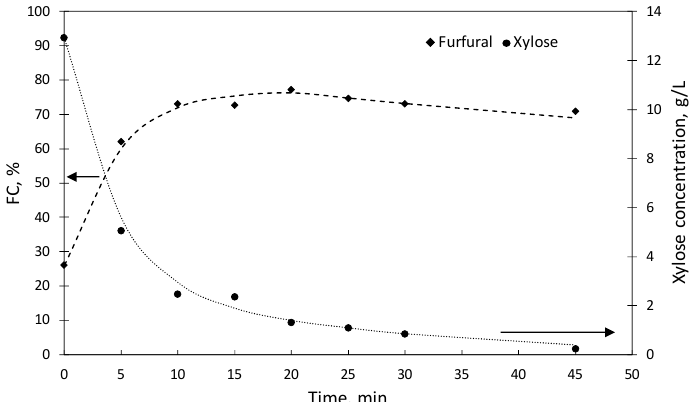
Figure 2. Molar conversions of potential substrates into furfural (FC) and xylose concentrations, obtained at 180 ◦ C in experiments using [C4mim]HSO 4 as a catalyst. Results were obtained at diverse reaction times in media containing 0.847 mol [C4mim]HSO 4 /L aqueous phase. When the catalyst loading decreased to 0.847 mol [C4mim]HSO 4 /L aqueous phase, the concentrations of furfural in the aqueous and organic phases were 0.612 ± 0.015 and 3.48 ± 0.004 g/L, respectively (corresponding to molar conversions of 5.7 ± 0.14 and 68.8 ± 0.08%,